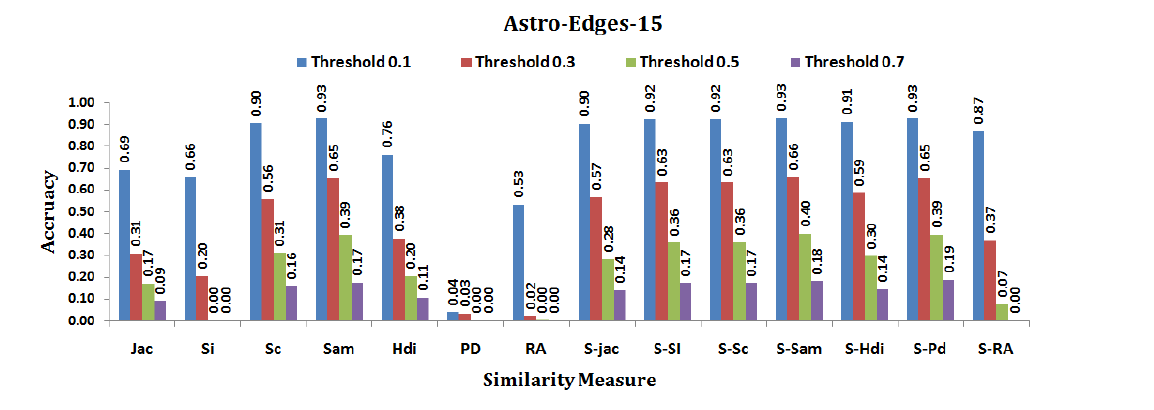
Figure 4. Prediction Results using Astro Dataset with 15%